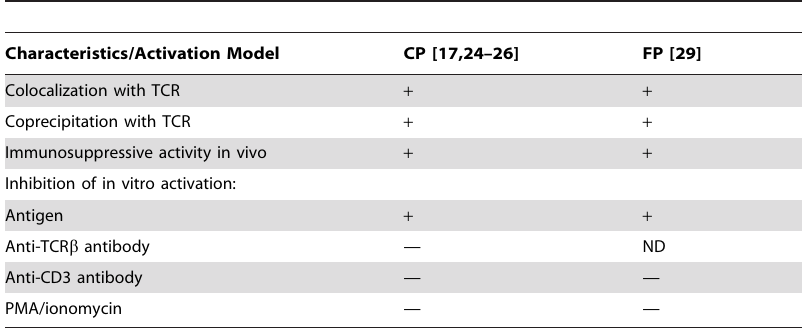
Table 1. Similarities in Characteristics and Immunomodulatory Activities of the T Cell Receptor Core Peptide and HIV-1 gp41 Fusion